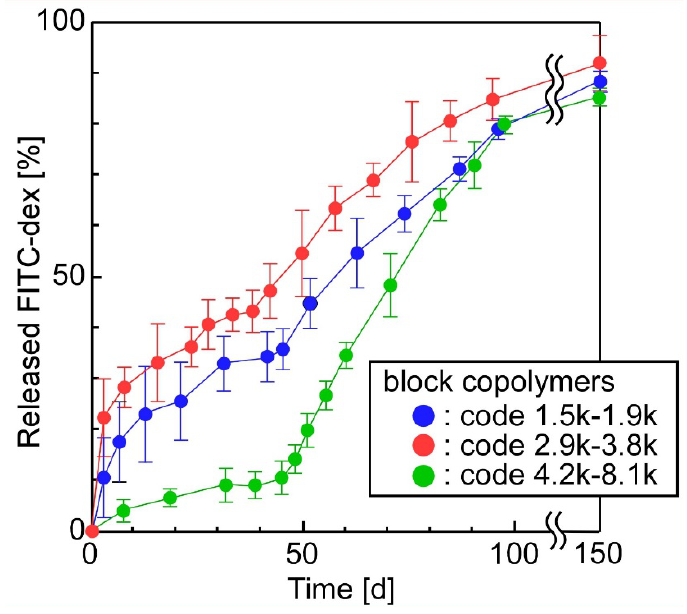
Figure 7. The effect of the composition of block copolymers on the release properties of the sheets (the sheet-forming polymers were PLA (2 w/v%) + PLGA (2 w/v%); number of layers: 11).